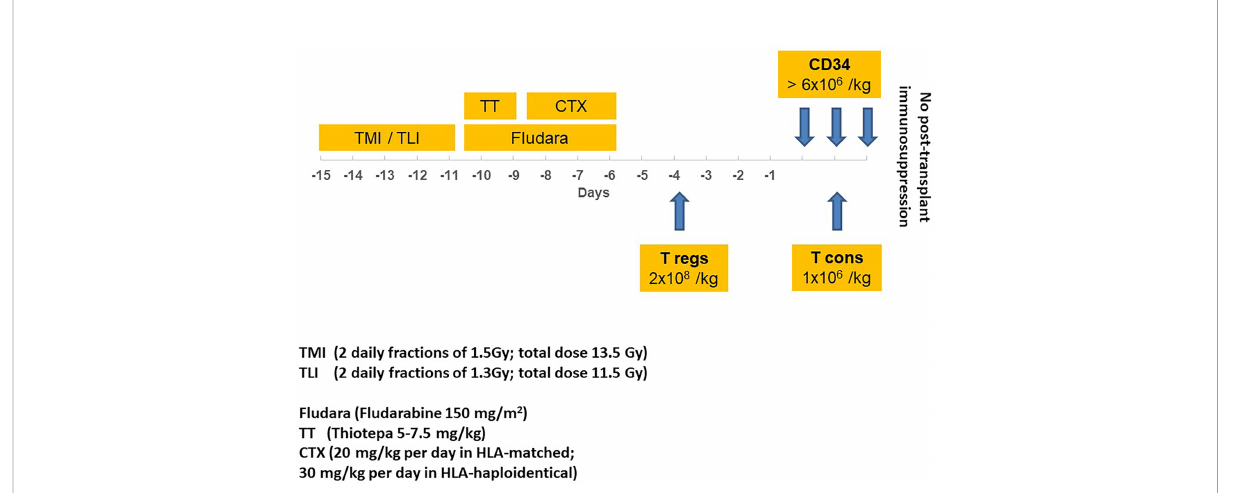
FIGURE 1 Transplantation schema, illustrating TMI/TLI* irradiation, drugs, timing, and immunotherapy before hematopoietic stem cell transplantation with